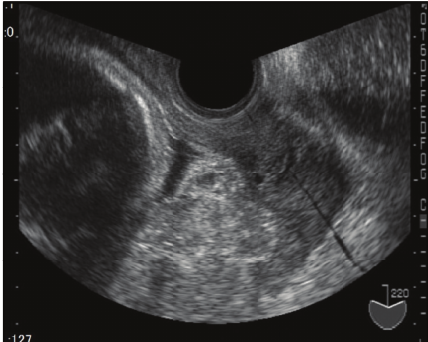
Figure 2: Two days after intrauterine fetal death (at 33 weeks and 4 days of gestation), the placenta previa was studded with irregular high-echo regions.